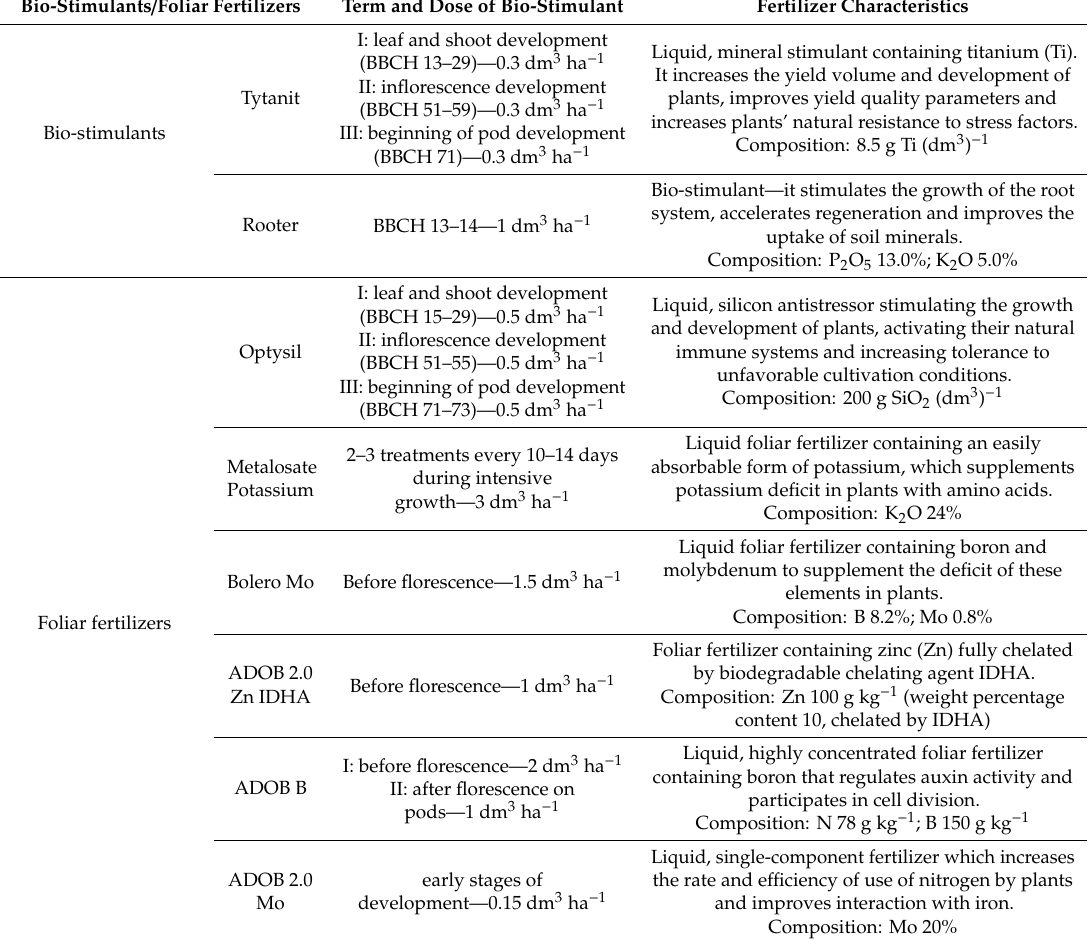
Table 1. The terms and doses of bio-stimulants and fertilizers applied in the experiment. Bio-Stimulants / Foliar Fertilizers